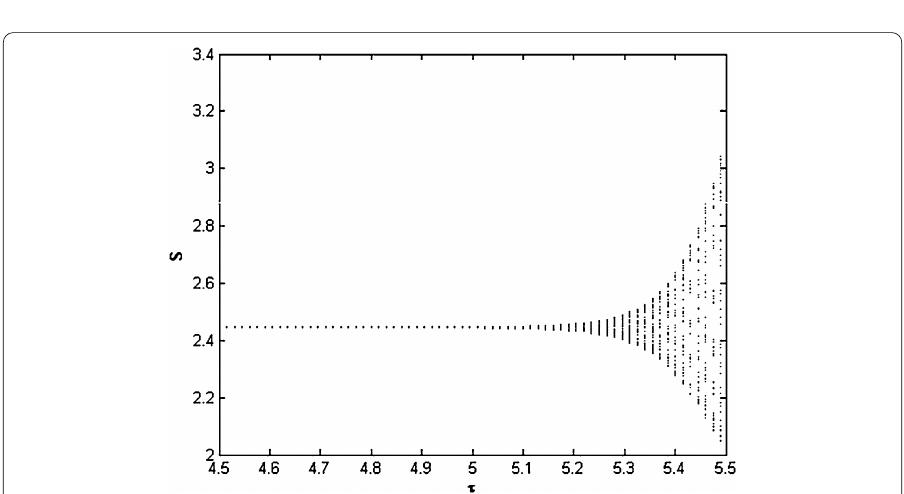
Figure 3 Bifurcation diagram with respect to τ